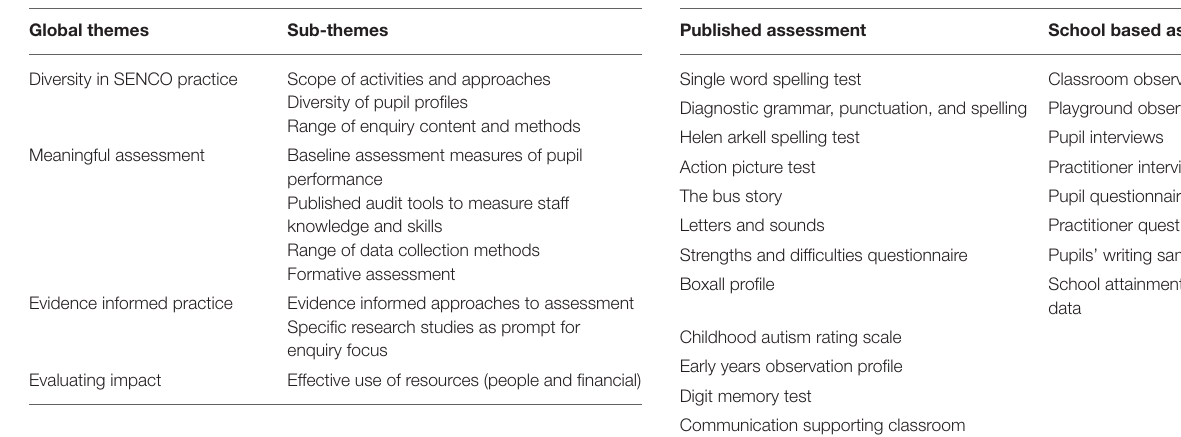
TABLE 1 | Themes underpinning SENCO practice. TABLE 2 | Summary of assessment methods employed by